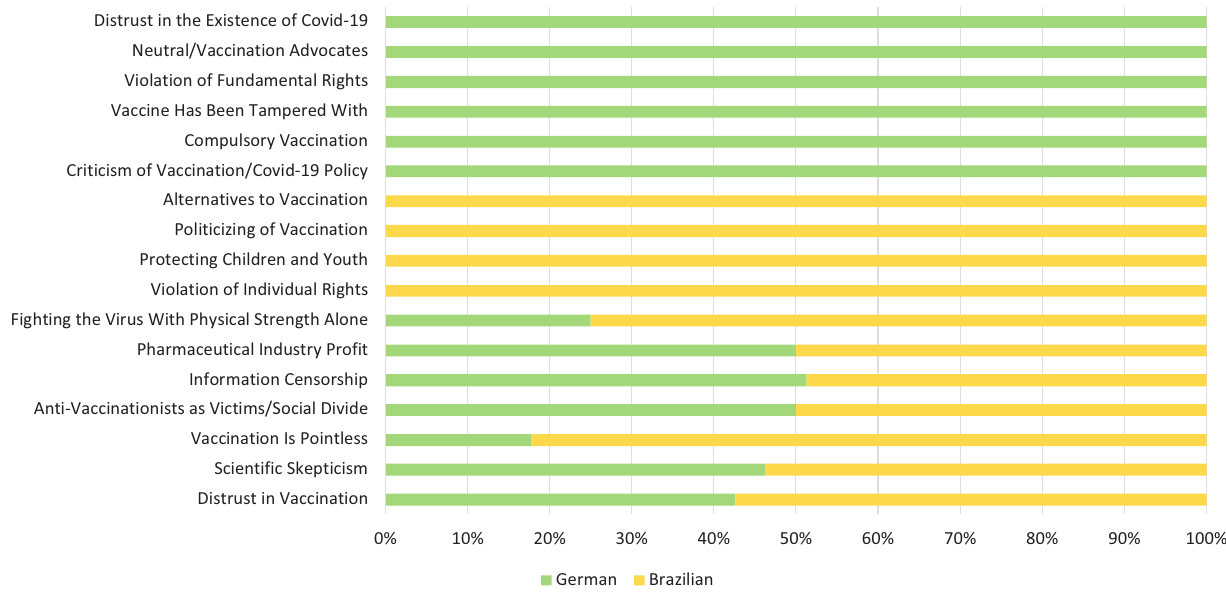
Figure 5. Occurrence of German and Brazilian